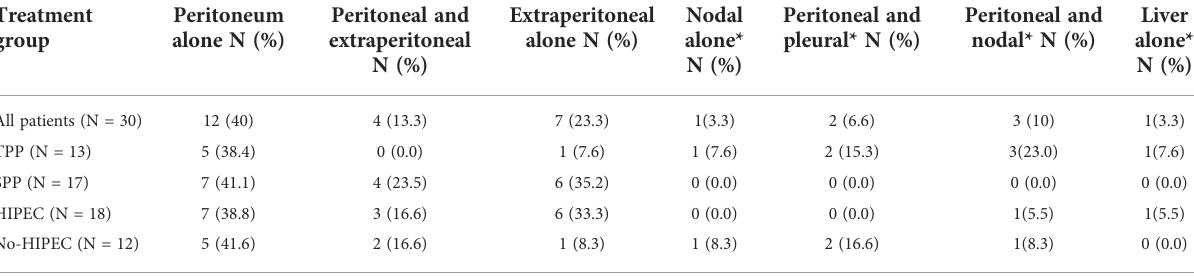
TABLE 8 Sites of recurrence in all 30 patients who developed early